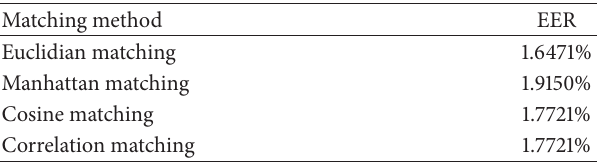
Table 2: Experimental result without